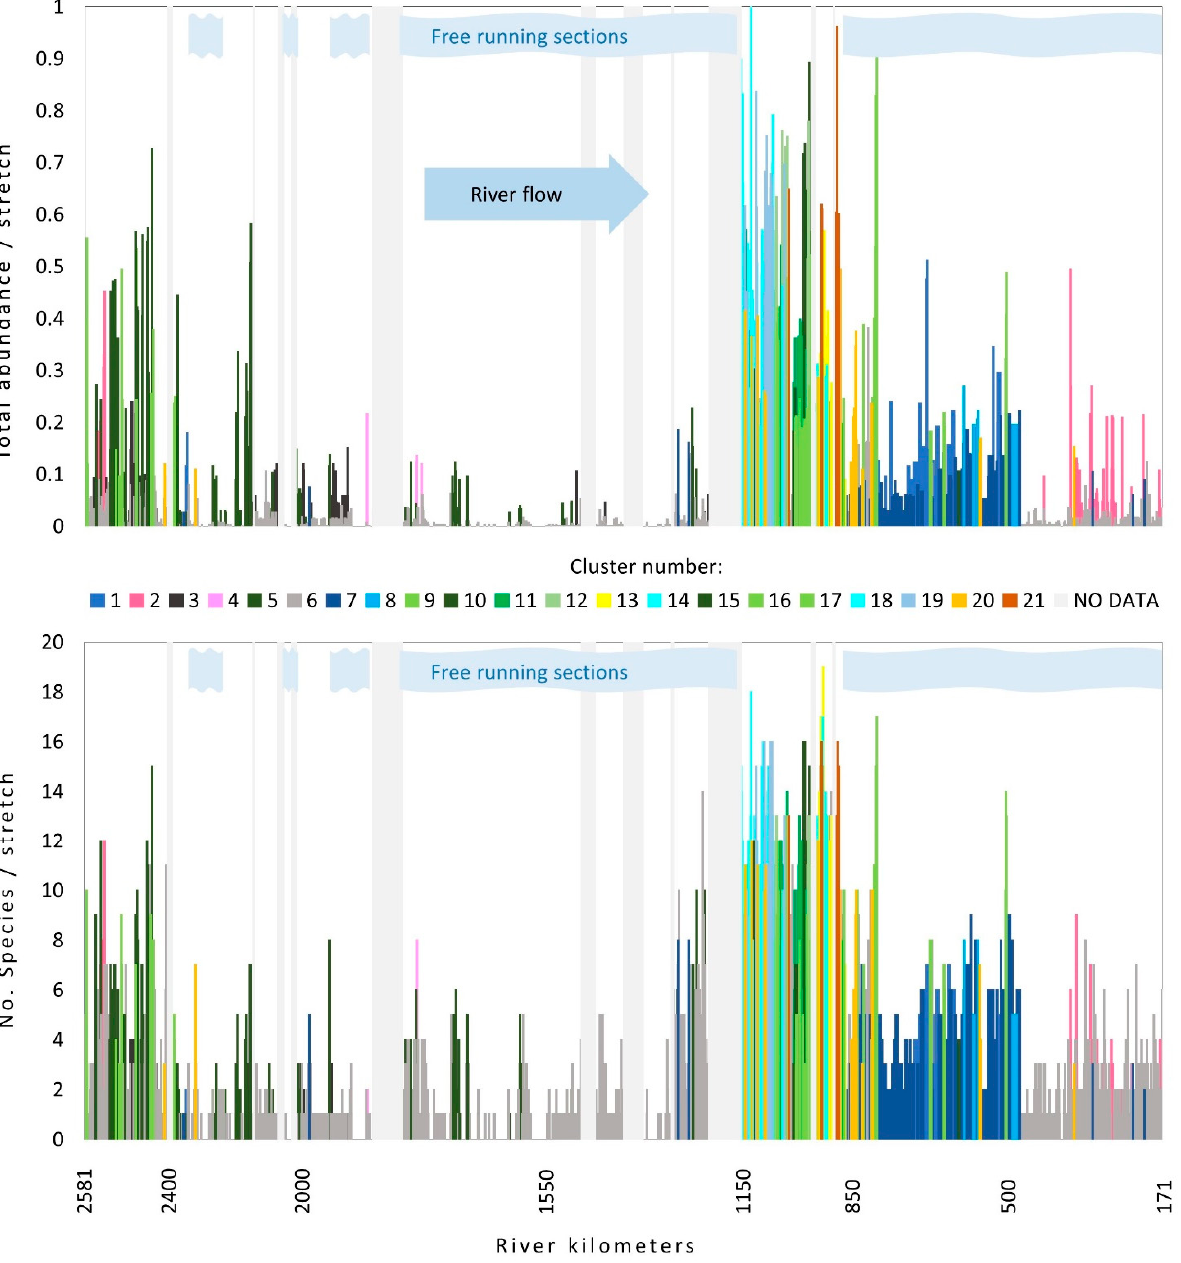
Figure 3. Changes in total species number (lower graph) and relative species abundance along the Danube River flow. Different colors indicate different clusters. Light grey vertical bars represent the sections with no data. Light blue stripes indicate sections where no influence of dams on the flow was detected. For cluster number information, see Table 1.